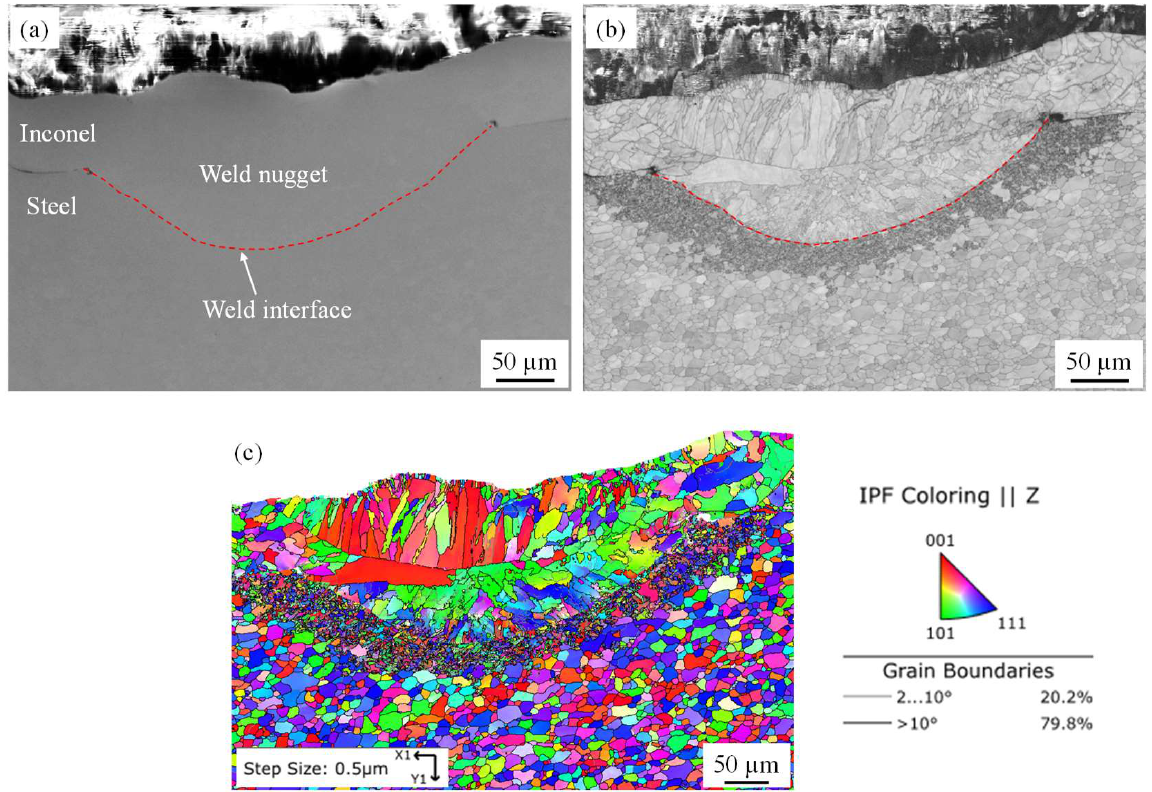
Figure 6. ( a ) SEM micrograph, ( b ) band contrast map and ( c ) EBSD map with IPF colouring of micro-RSW welded joint interface at good weld without any microcrack condition.